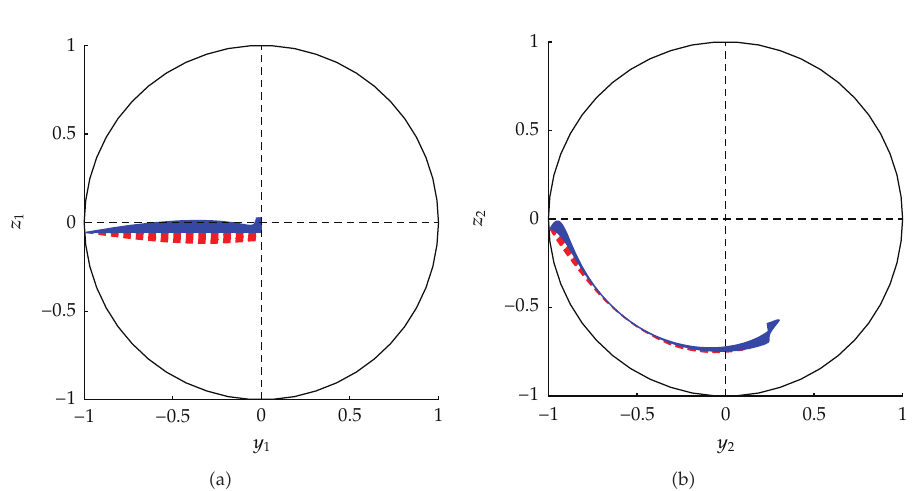
Figure 3: Projection of the singular flow onto the planes (cid:3) y 1 ,z 1 (cid:4) and (cid:3) y 2 ,z 2 (cid:4) in the cerebrospinal fluid/water case. The trajectories are plotted in black (cid:3) solid line (cid:4) and in red (cid:3) dashed line (cid:4) . The control fields of the dashed extremals diverge. The trajectories have been plotted up to the explosion of the field (cid:3) the absolute value is then larger than 10 5 (cid:4) . The horizontal and vertical dashed lines represent the y - and z -axes of the Bloch ball. Note the contrast that can be obtained between the two spins, which illustrates the role of the singular flow in this